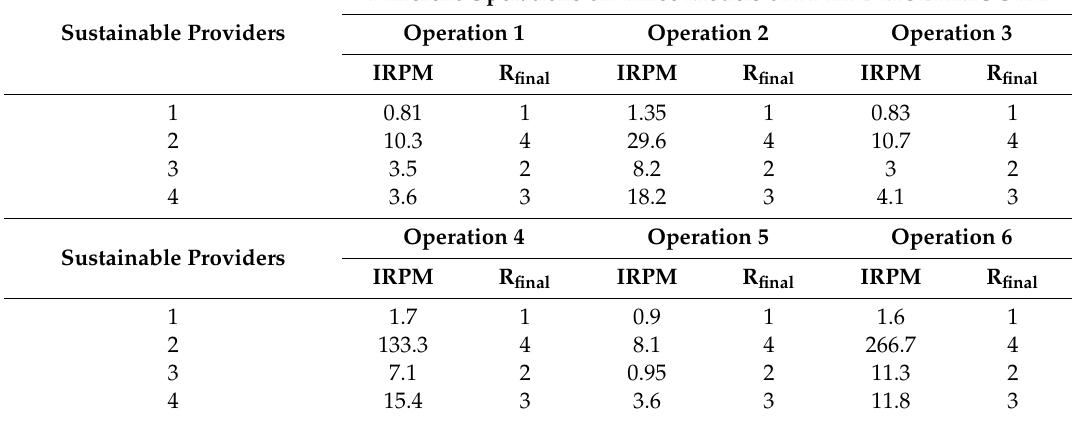
Table 10. Sensitivity analysis of PDHFL-MULTIMOORA. Di ff erent Operations on Three Models of Sustainable Providers